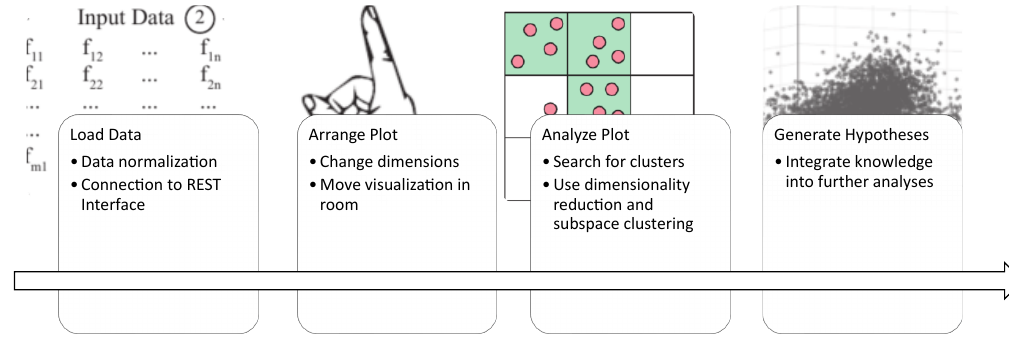
Figure 6. Overall workflow of the implemented prototype and the CLIQUE algorithm.